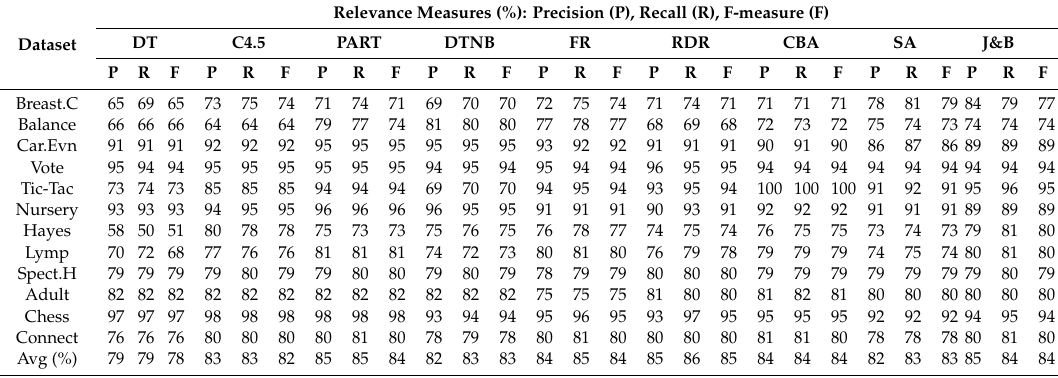
Table A1. Weighted relevance